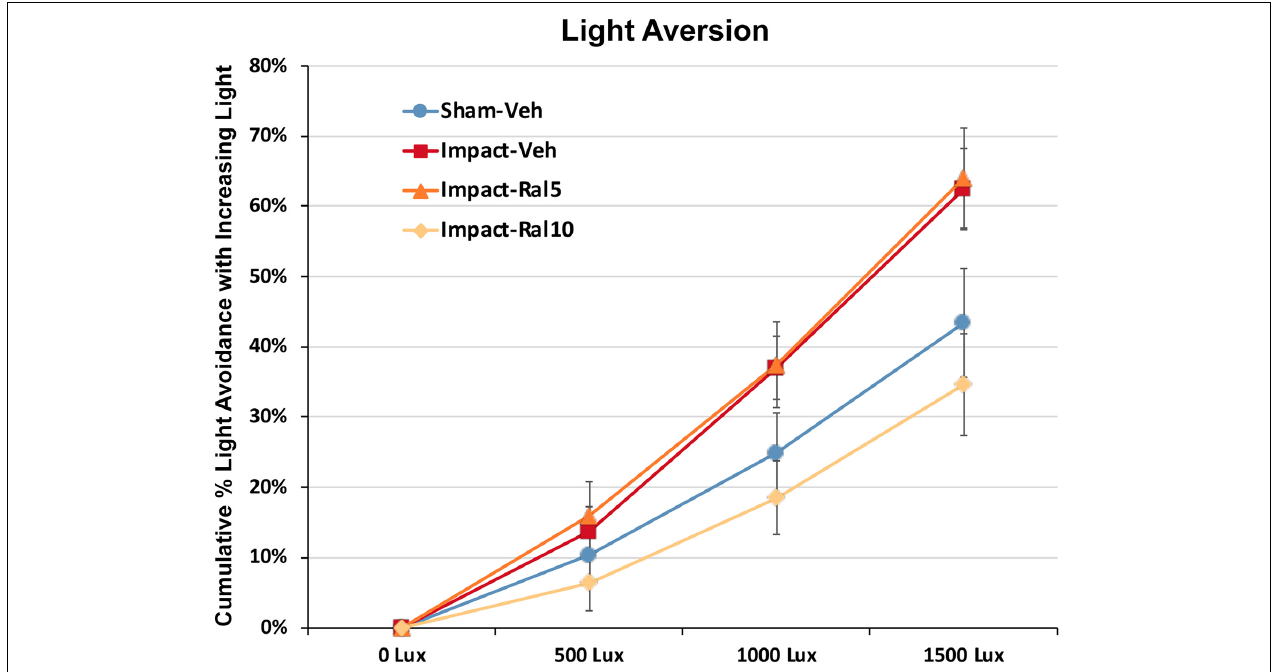
FIGURE 3 | Light aversion at ∼ 5 months after impact. Light aversion was plotted as cumulative avoidance of an enclosed chamber with increasing brightness, relative to an adjacent dark chamber. Impact-vehicle mice and impact-ral5 mice showed greater avoidance of the enclosed chamber with increasing light intensity than sham-vehicle mice across the three levels of illumination ( p = 0.031). Mice treated with 10 mg/kg raloxifene, however, exhibited less light aversion than impact-vehicle mice ( p = 0.029) and impact-ral5 mice ( p = 0.033) but not significantly differently than sham mice. Thus, 10 mg/kg raloxifene, but not 5 mg/kg, rescued the increase in light aversion that resulted from impact TBI. Errors bars are SEMs. Animal numbers: 16 sham-vehicle mice, 20 impact-vehicle mice, 17 impact-ral5 mice, and 14 impact-ral10 mice.